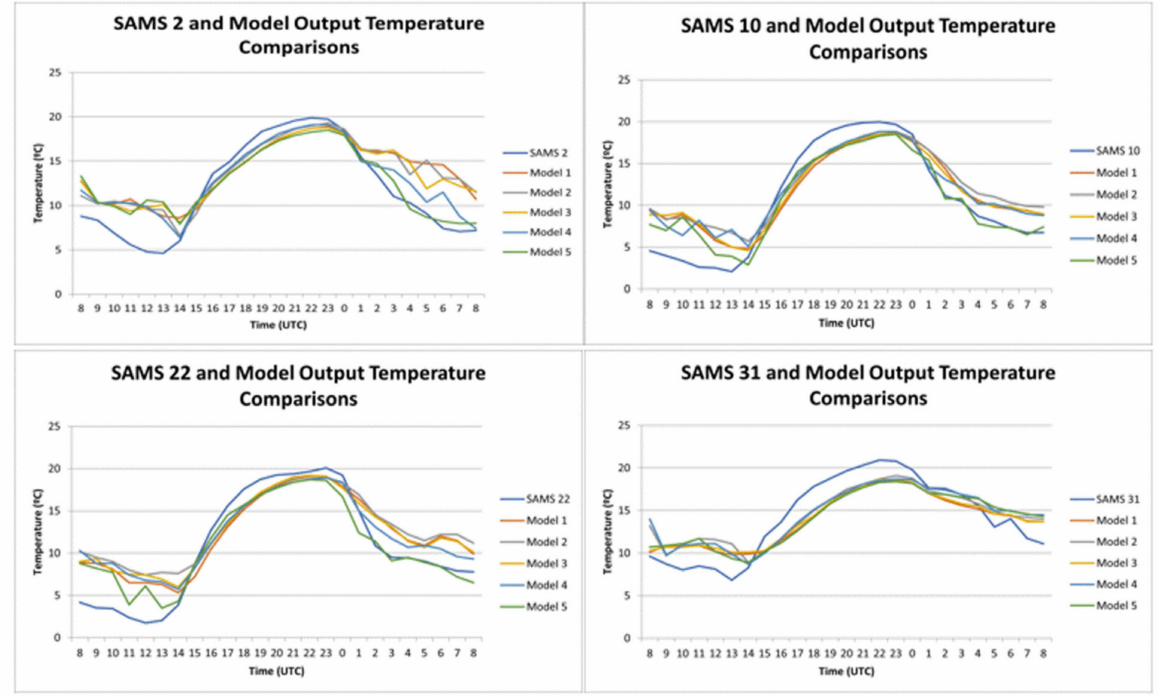
Figure 7. Observed 2 m AGL surface temperature ( ◦ C) compared with model-simulated 2 m AGL surface temperature ( ◦ C) for the different experiments MS1 through MS5 across IOP6 at several different SAMS off-playa sites as shown in Figure